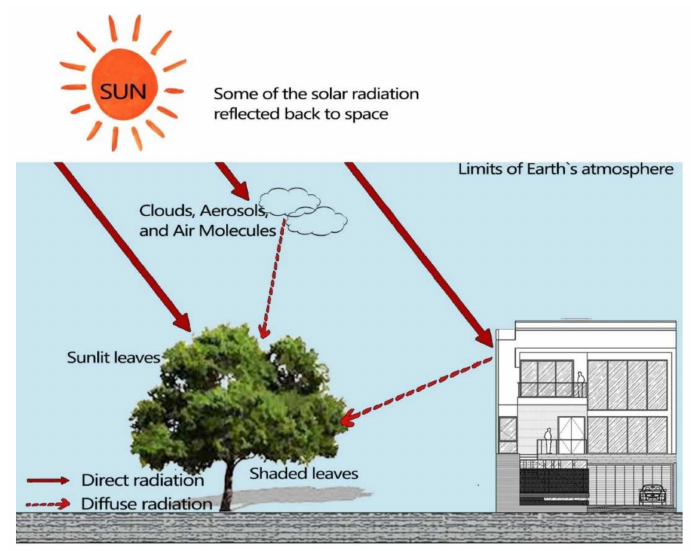
Figure 14. Diagram of the surface energy balance.